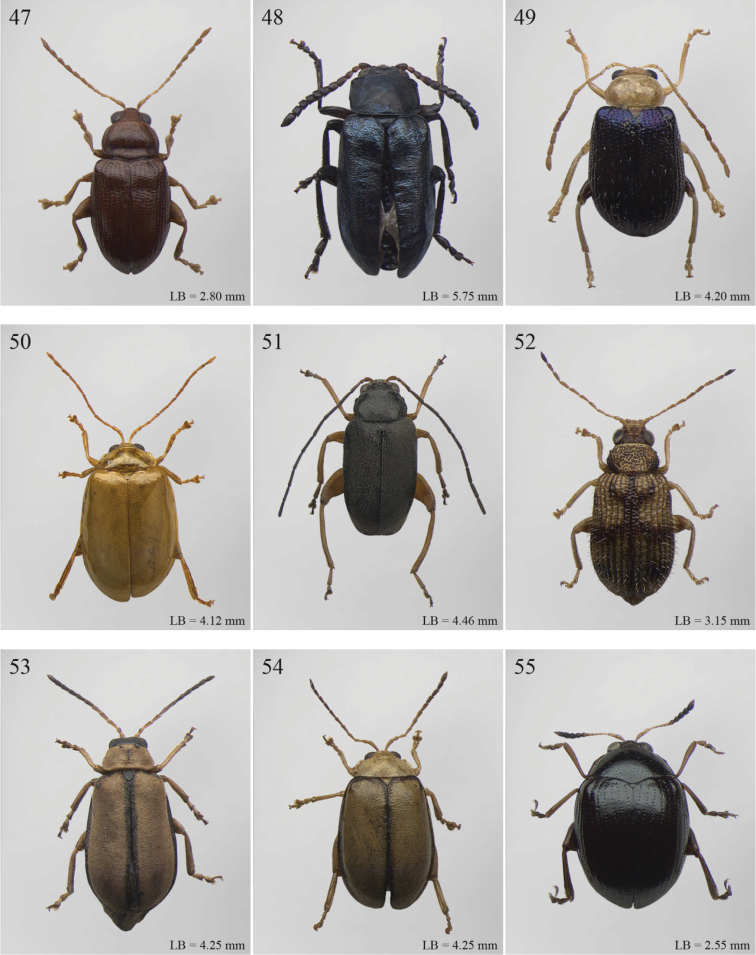
Habitus. 47
Guinerestia rubra Scherer 48
Halticopsis spissicornis Fairmaire (genus transferred to Galerucini) 49
Halticotropis costipennis Bechyné 50
Hemipyxis africana (Allard) 51
Hespera africana Jacoby 52
Hildebrandtina similis Bechyné 53
Homichloda barkeri (Jacoby) 54
Hyphasis sita (Maulik) 55
Jacobyana bezdeki Biondi & D’Alessandro.